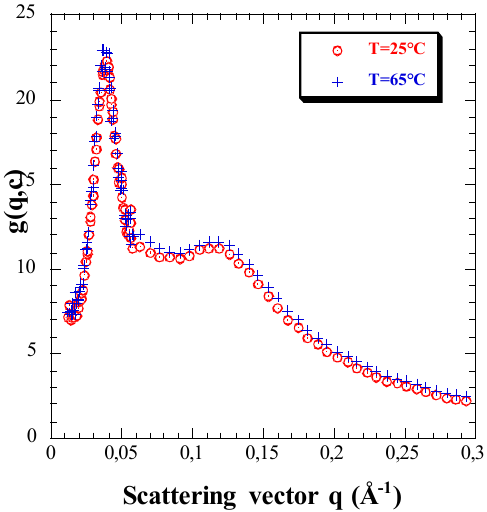
Figure 4. Scattering functions of the same NaPSS star solution (S100-S91 in D 2 O at c = 0.480 mol·L − 1 – φ = 5.34%; c > c * = 0.075 mol·L − 1 – φ * = 0.83%) at two distinct temperatures 25 °C (circles) and 65 °C (crosses).